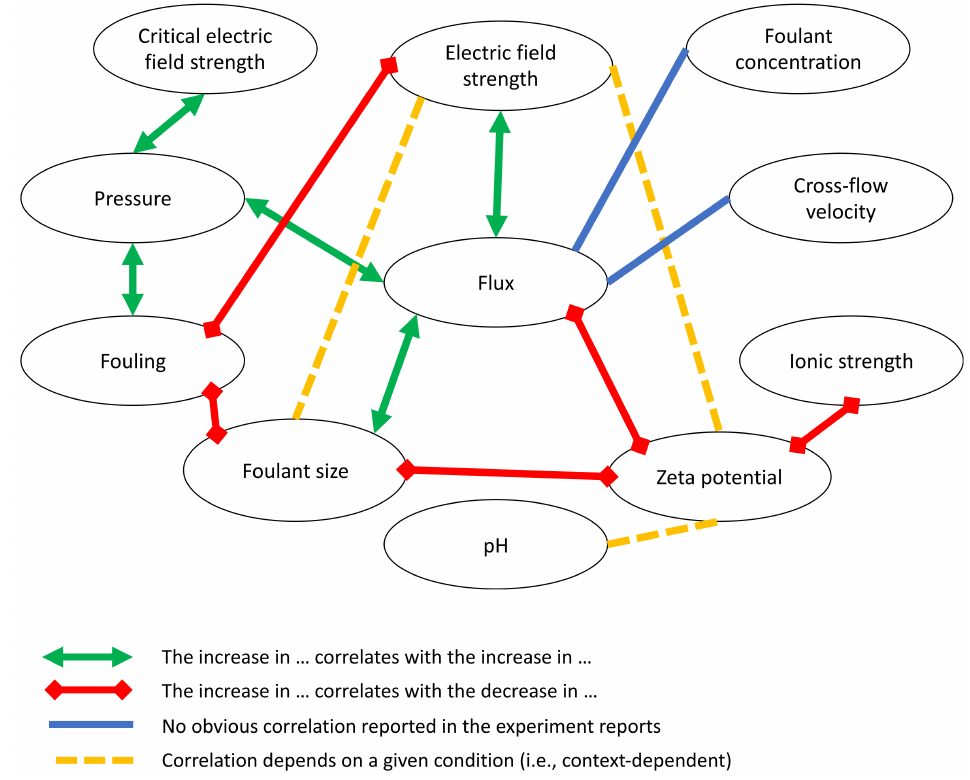
Figure 8. Summary of effects of various experiment factors on fouling and flux from the electrofiltra- tion